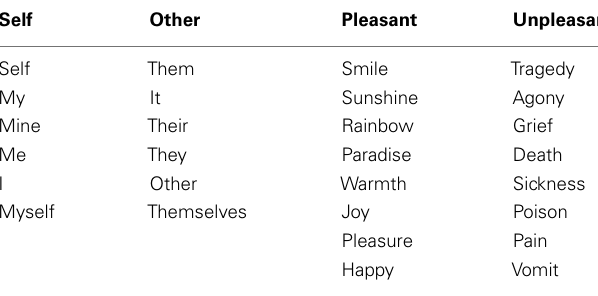
Table 2 | IAT stimulus